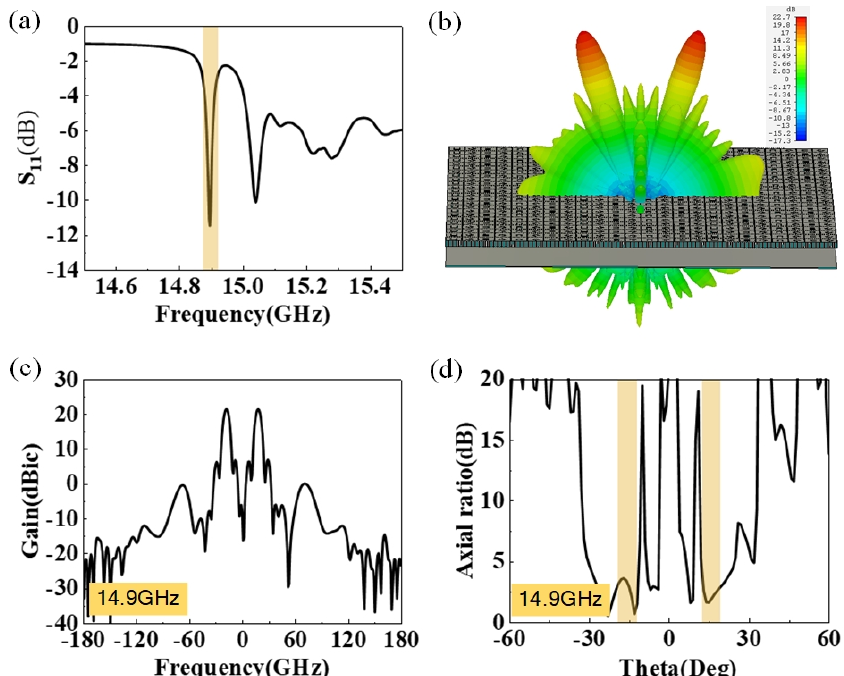
Figure 5. ( a ) The S11 of the FP antenna for generating split CP dual beams in the direction of θ = ±18°. ( b ) Far-field 3D patterns of the split CP dual beams. ( c ) Far-field patterns in yx-plane of the split CP dual beams in the direction of θ = ±18° at 14.9 GHz. ( d ) Axial ratios of the FP antenna at 14.9 GHz.